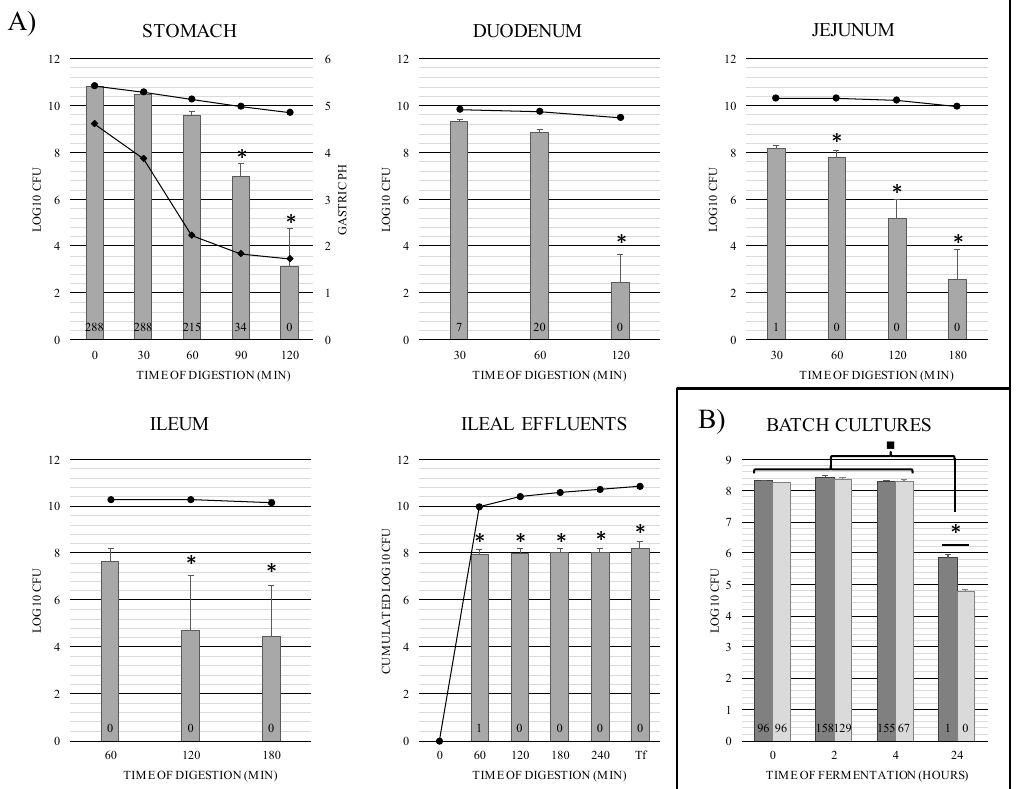
Figure 4. Bacterial survival and number of activated R ‐ IVET clones obtained and analyzed in each TIM ‐ 1 compartment ( A ) and in fecal microbiota batch cultures ( B ). ( A ) In each TIM ‐ 1 compartment, data points obtained for the R ‐ IVET library and the theoretical transit marker are represented by gray bars and black circle curves, respectively. In the stomach compartment, the black diamond curve gives the gastric pH evolution over time. Tf represents the cumulated ileal effluents plus gastrointestinal residue collected at the end of TIM ‐ 1 experiment. Values are given as means of log 10 CFU ± SEM ( n = 3). At each time, results for the R ‐ IVET library were compared to those of the transit marker. Significant differences are noted by asterisks (ANOVA and Bonferroni test, p < 0.05). Numbers in bars correspond to the total number of activated R ‐ IVET clones obtained and analyzed at each time point. ( B ) For batch cultures, dark ‐ gray bars and light ‐ gray bars represent data from volunteer 1 (man) and volunteer 2 (woman), respectively. Values are given as means of log 10 CFU ± SEM (four technical replicates). Values at each time point were compared to those obtained at T 0 ( p < 0.05) and between each volunteer (* p < 0.05). Numbers in bars correspond to the total number of activated R ‐ IVET clones analyzed at each time point.